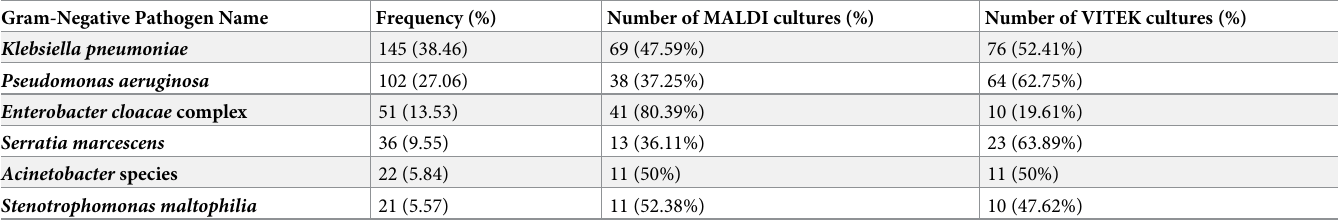
Table 1. Frequencies of gram-negative pathogens among patient cultures (n = 377) and percentage of cultures per testing modality. Gram-Negative Pathogen